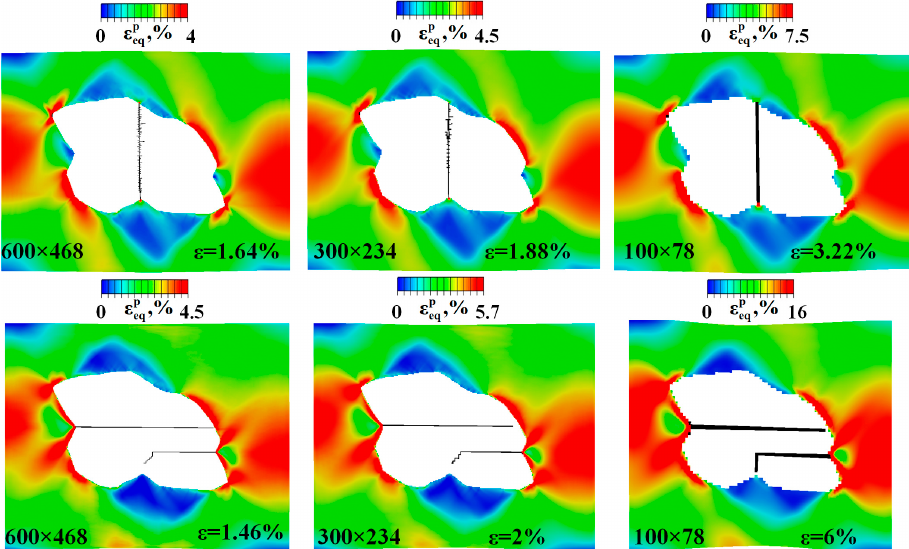
Figure 4. Fracture pa tt erns under compression ( a , b ) or tension ( c ) or of the Al-TiC ( a ) and Al-B 4 C composites ( b , c ).